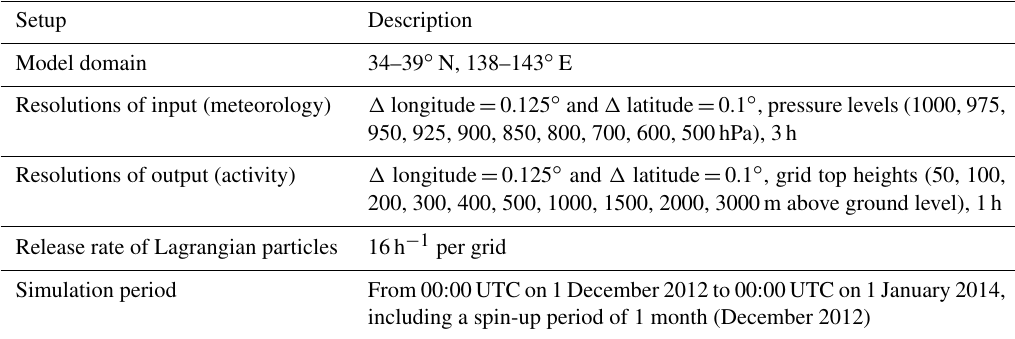
Table 1. Summary of simulation